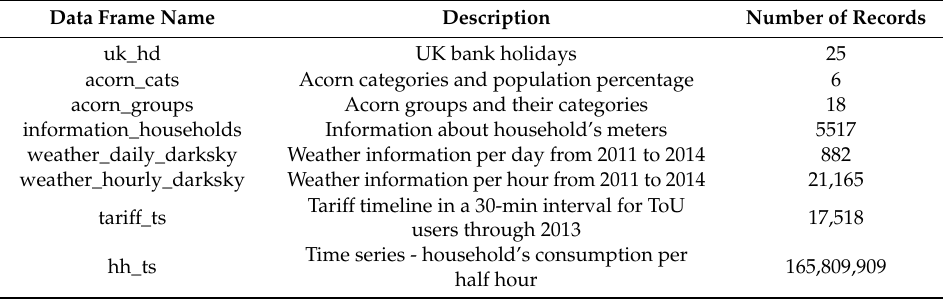
Table 2. Initial data frames generated from data